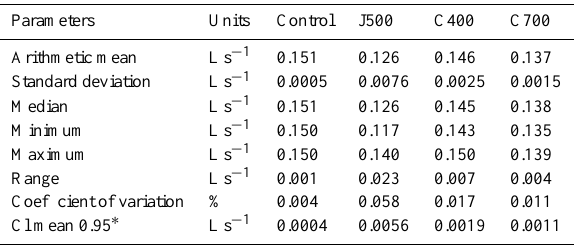
Figure 3. Surface run-off volume at time = 15min, R 15 (L); linear trend lines included; laboratory conditions.